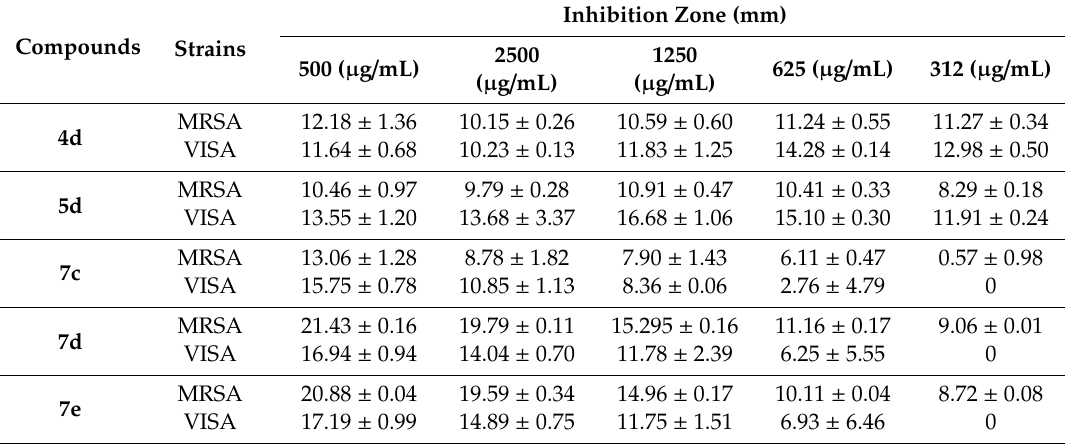
Table 1. Zone of inhibition of methicillin-resistant Staphylococcus aureus (MRSA) and vancomycin- intermediate S. aureus (VISA) measured by agar di ff usion assay.